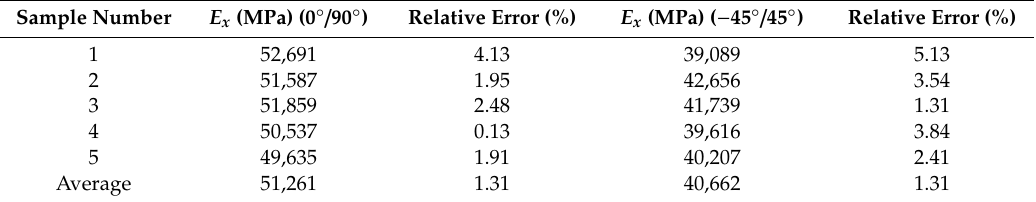
Figure 3. Photograph of experimental verification of computed mechanical properties of the composite rectangular samples. Table 3. Experimental verification of mechanical properties of the composite rectangular samples.